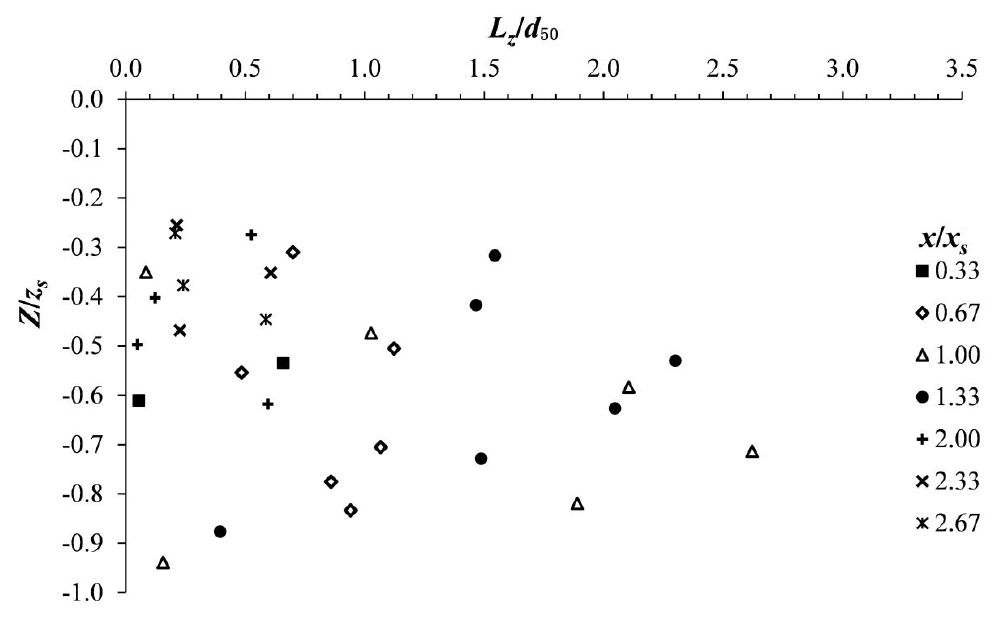
Figure 8. Vertical profiles of normalized turbulent length scales, L z / d 50 , at di ff erent downstream positions x / x s at the plane of flow symmetry ( y =